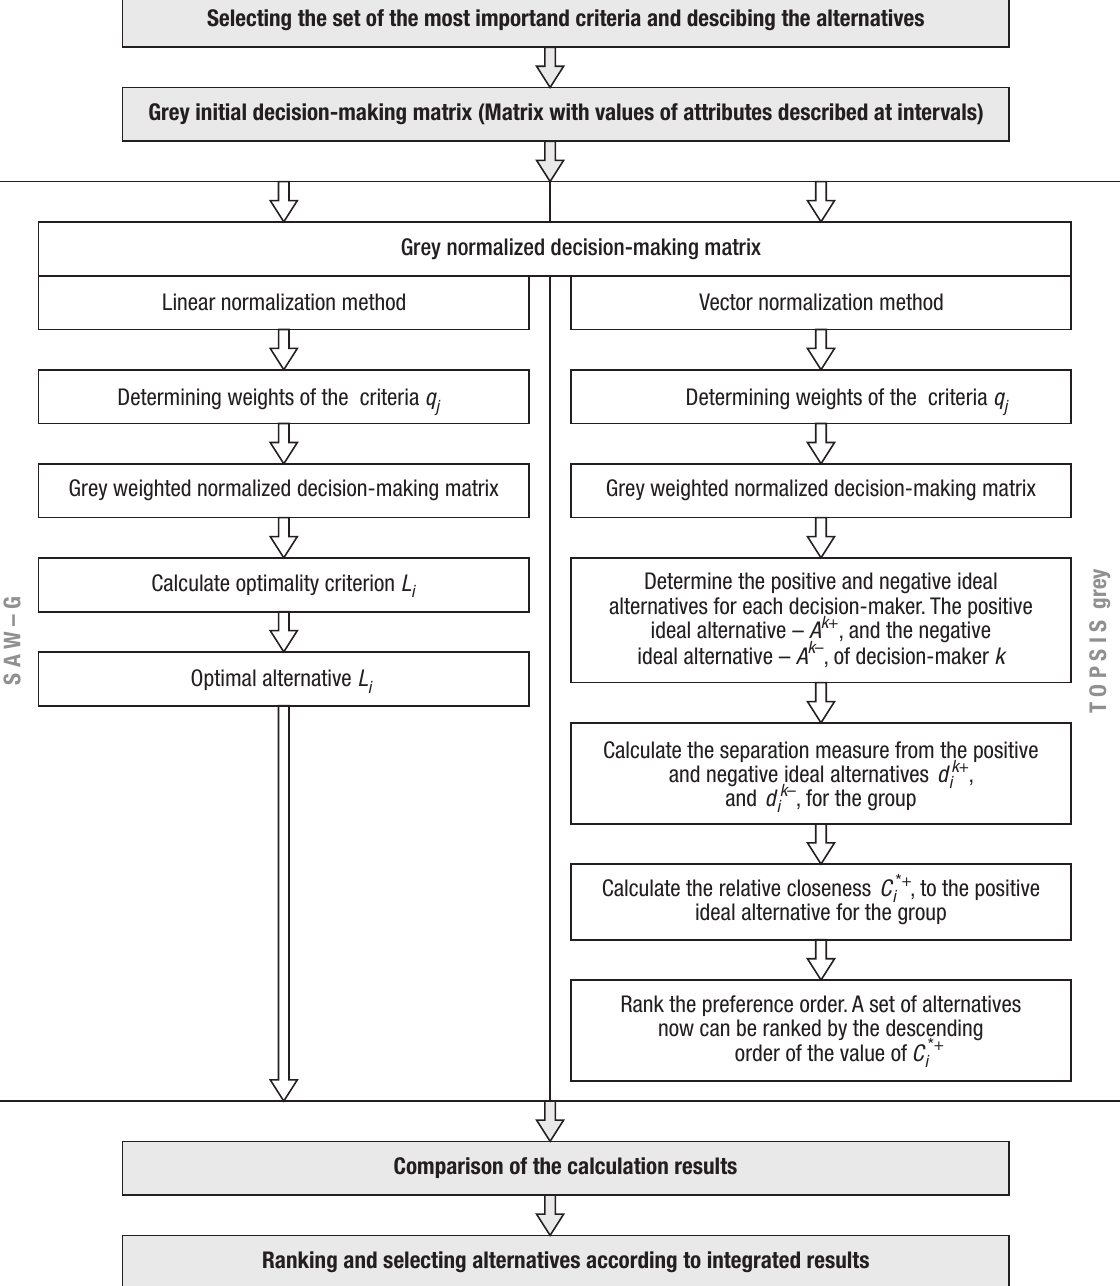
Comparison of the calculation results